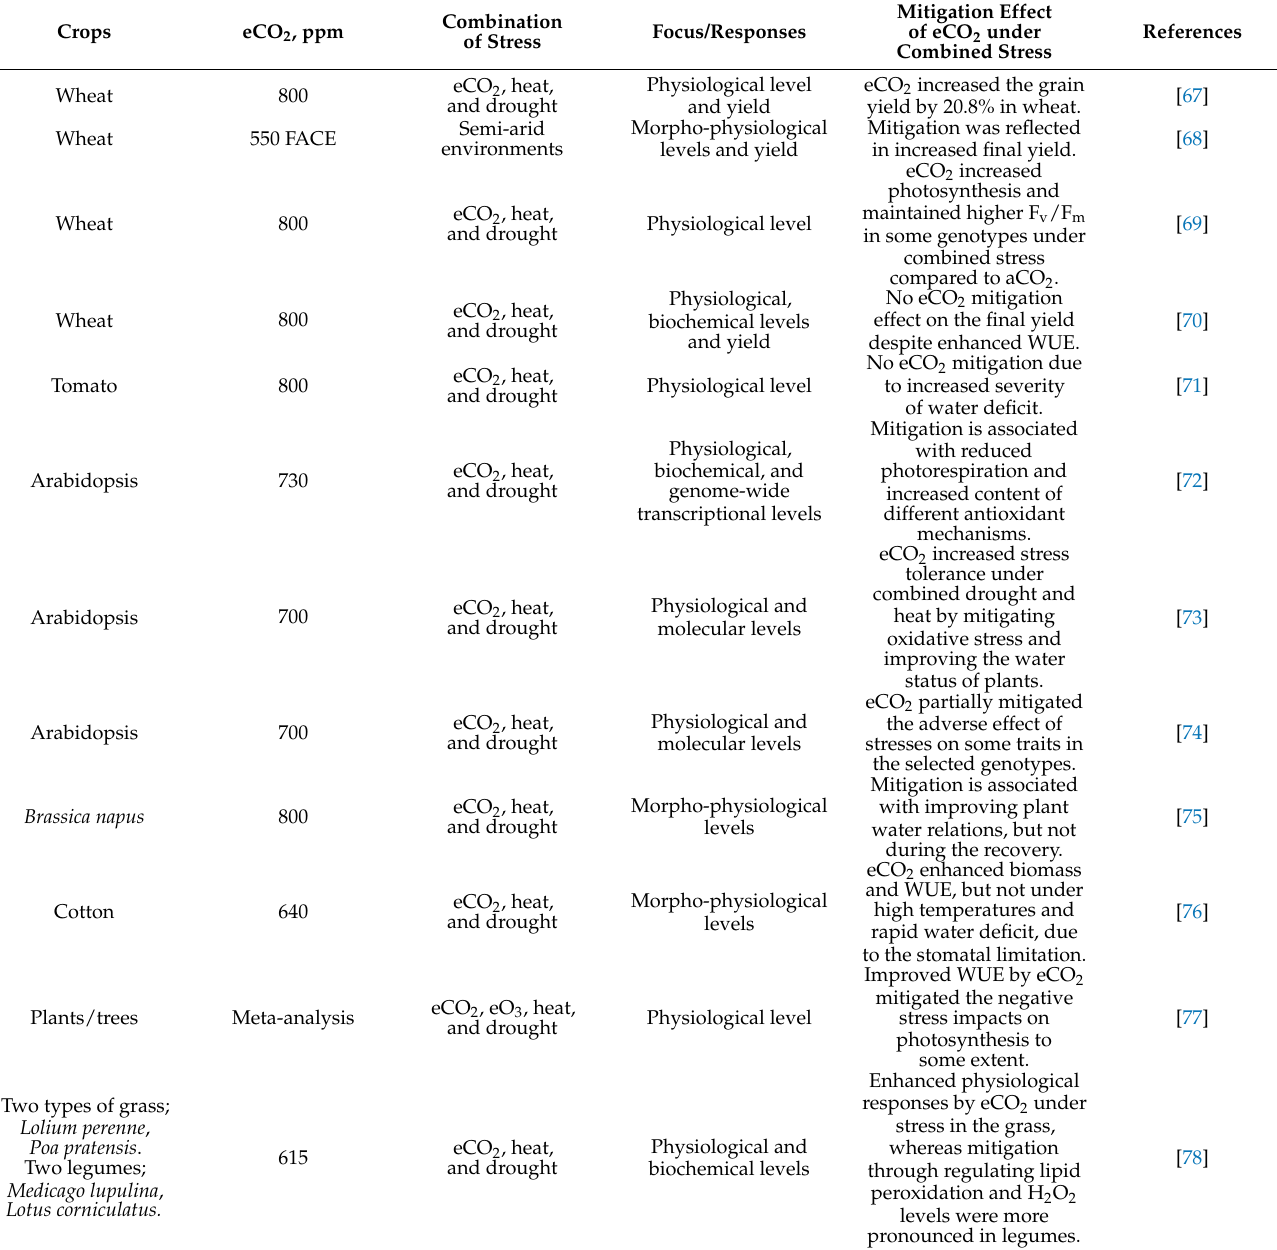
Table 1. Overview of studies investigating the responses under the combination of drought and heat stresses and elevated CO 2